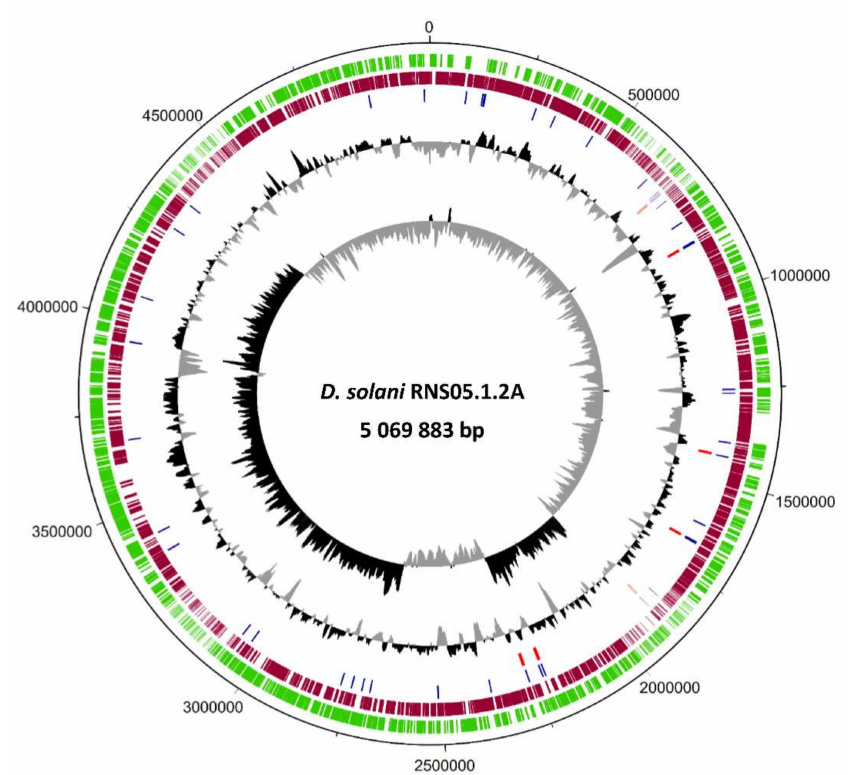
Figure 1. A circular map of D. solani RNS05.1.2A chromosome sequence. The genome map was generated using DNAPlotter. The two inner circles show the GS-skew plotter, followed by GC content. The red bars indicate positions of the rRNAs’ genes and the blue ones indicate the tRNAs’. The coding sequences are indicated by bars in green (forward direction) and dark red (reverse direction).